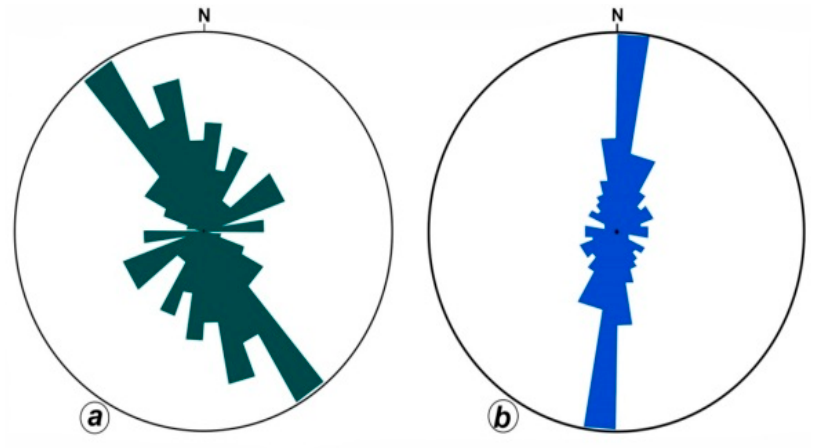
Figure 13. Rose diagram of trends of natural fractures measured in image logs ( a ); Rose diagram of trends of natural fractures from core analysis ( b ).